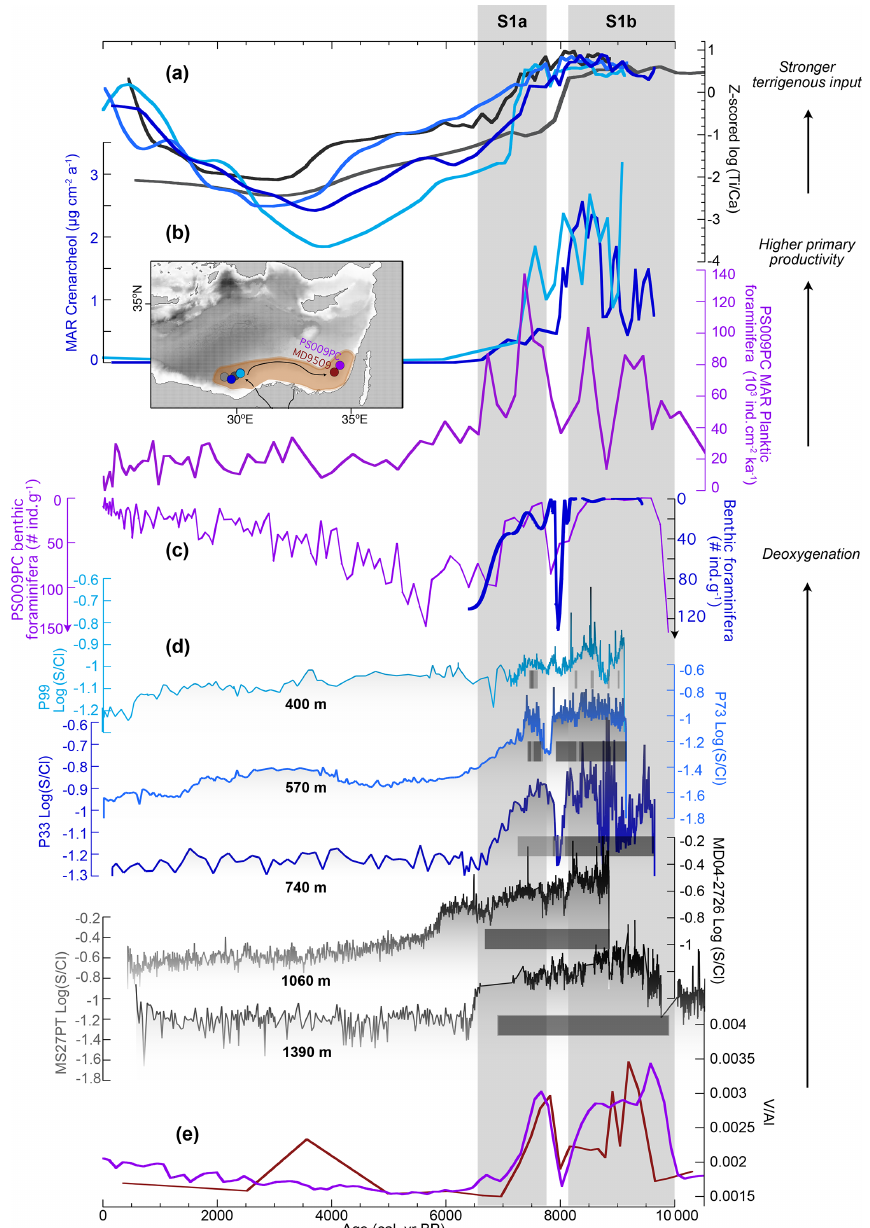
Figure 11. Regional compilation of changes in terrigenous, primary productivity and oxygenation conditions during the Holocene. (a) Standardized ( z score) records of log (Ti / Ca) of cores P99 (light blue), P73 (blue), P33 (dark blue), MD04-2726 (dark grey), MS27PT (grey) (Revel et al., 2015). Z scoring ( x -mean(Ex)/SD) allows comparison of trends in a similar proxy from different archives by scaling the y range and aligning the means on 0. (b) MAR of crenarchaeol in cores P99 (light blue) and P33 (dark blue), planktonic foraminifera in core PS009PC (purple) (Mojtahid et al., 2015). (c) Abundance of benthic foraminifera in core P33 (cubic spline, dark blue, inverse y scale) and core PS009PC (purple). (d) Log (S / Cl) records and lamination patterns in cores from the Nile DSF (shallower to deeper core site from top to bottom): P99 (light blue), P73 (blue), P33 (dark blue), MD04-2726 (dark grey), MS27PT (grey) (Revel et al., 2015). (e) V / Al records in cores PS009PC (purple) (Hennekam et al., 2014) and MD9509 (brown) (Matthews et al., 2017). Grey vertical bars: sapropel S1a and S1b; lighter grey bars: periods of slight reoxygenation; white bar: S1 interruption (at ca. 8kaBP). Map in (b) showing the location of the cores along the path of the Levantine